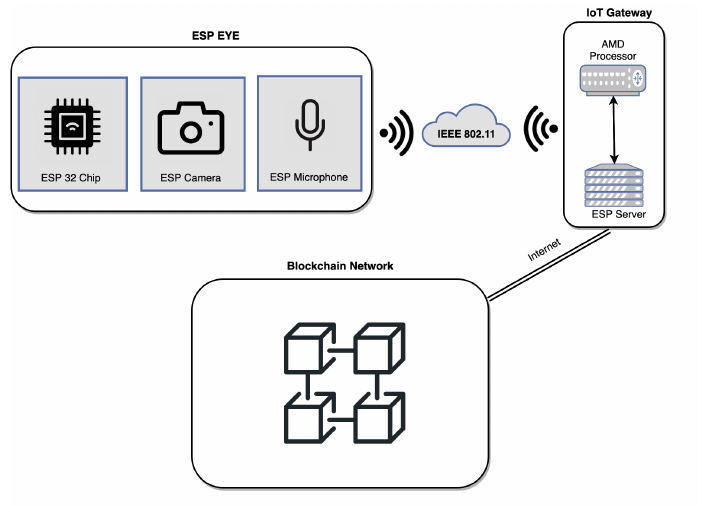
Figure 3. Hardware